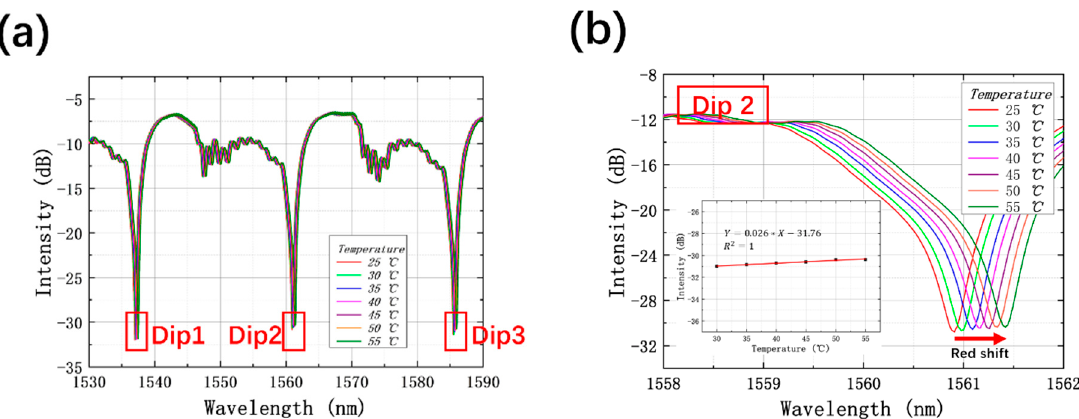
Figure 7. ( a ) Transmission spectra of the HCBF-based sensor under different temperature values; ( b ) enlarged transmission spectra in the region of Dip 2, inset shows the relationship between the intensity of Dip 2 and temperature.